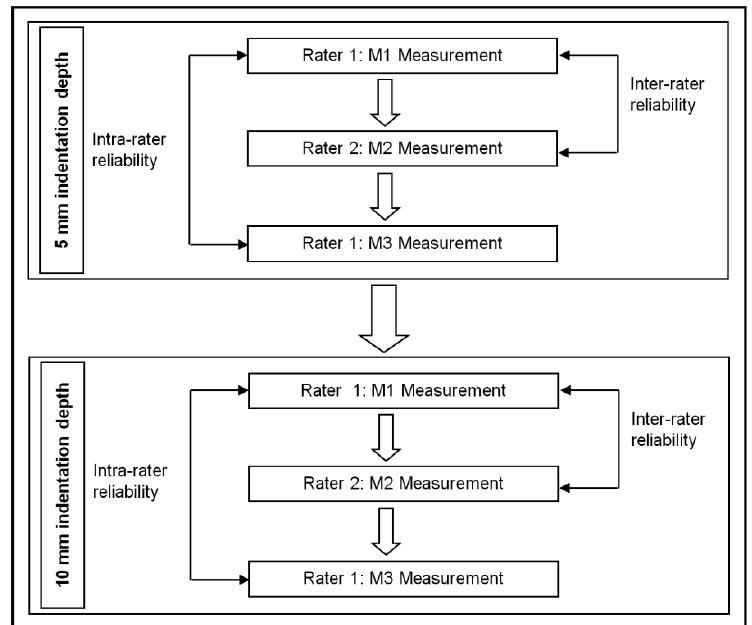
Figure 3. Chart displaying the workflow of reliability testing.